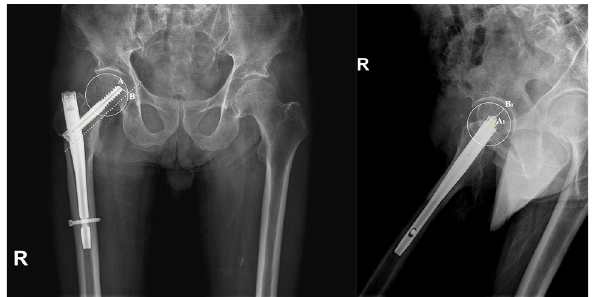
Figure 5. Assessment of the CalTAD in the anterior–posterior plane and the lateral plane. The Calcar Tip Apex Distance (CalTAD) is represented by the sum of AB and A 1 B 1 distance.